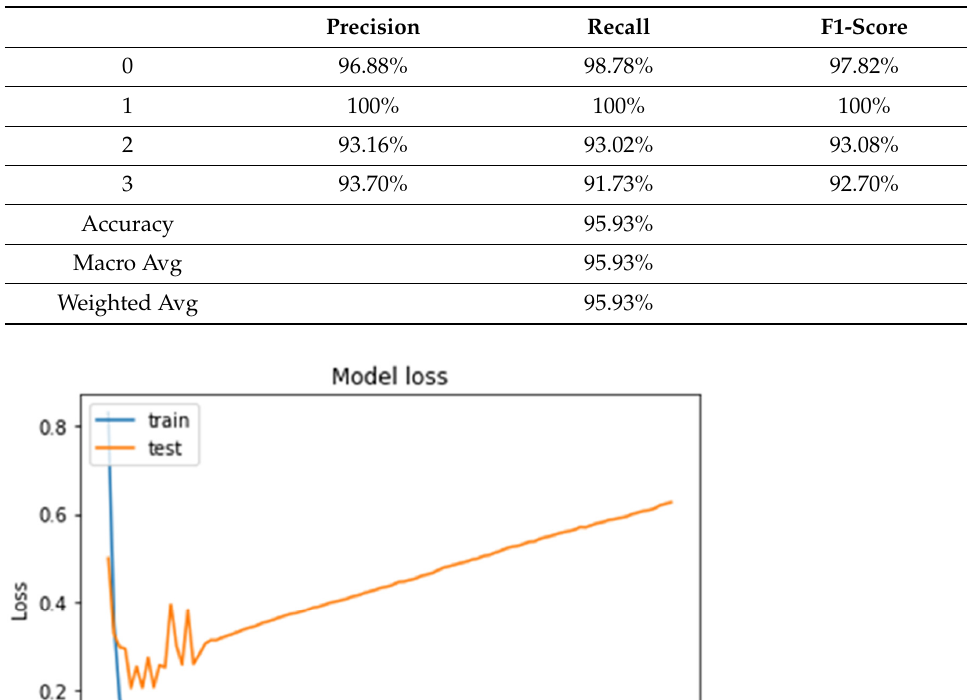
Table 5. The performance of the proposed model for multi-classification task.